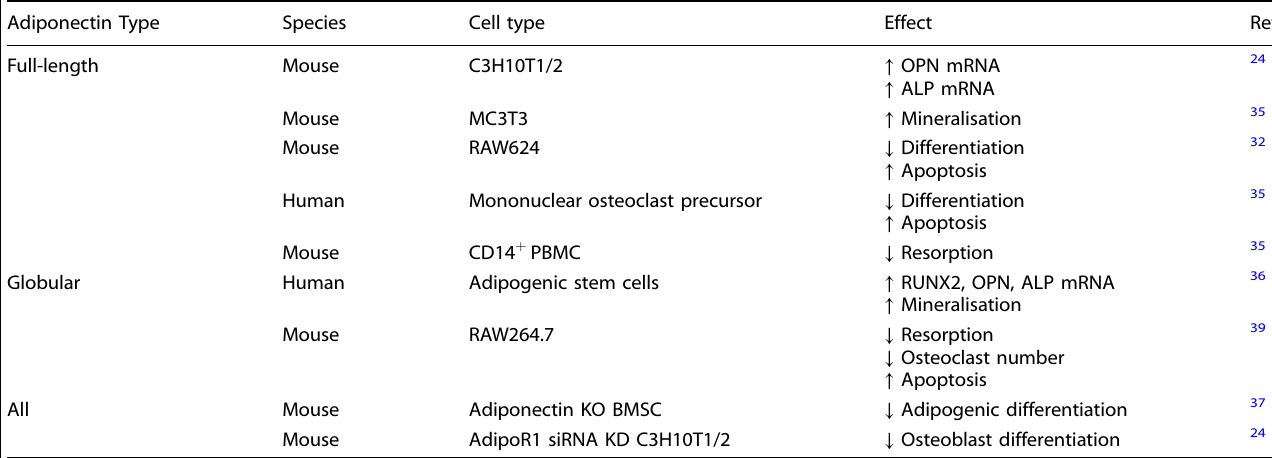
Table 1. In vitro effects of adiponectin on bone cells Adiponectin